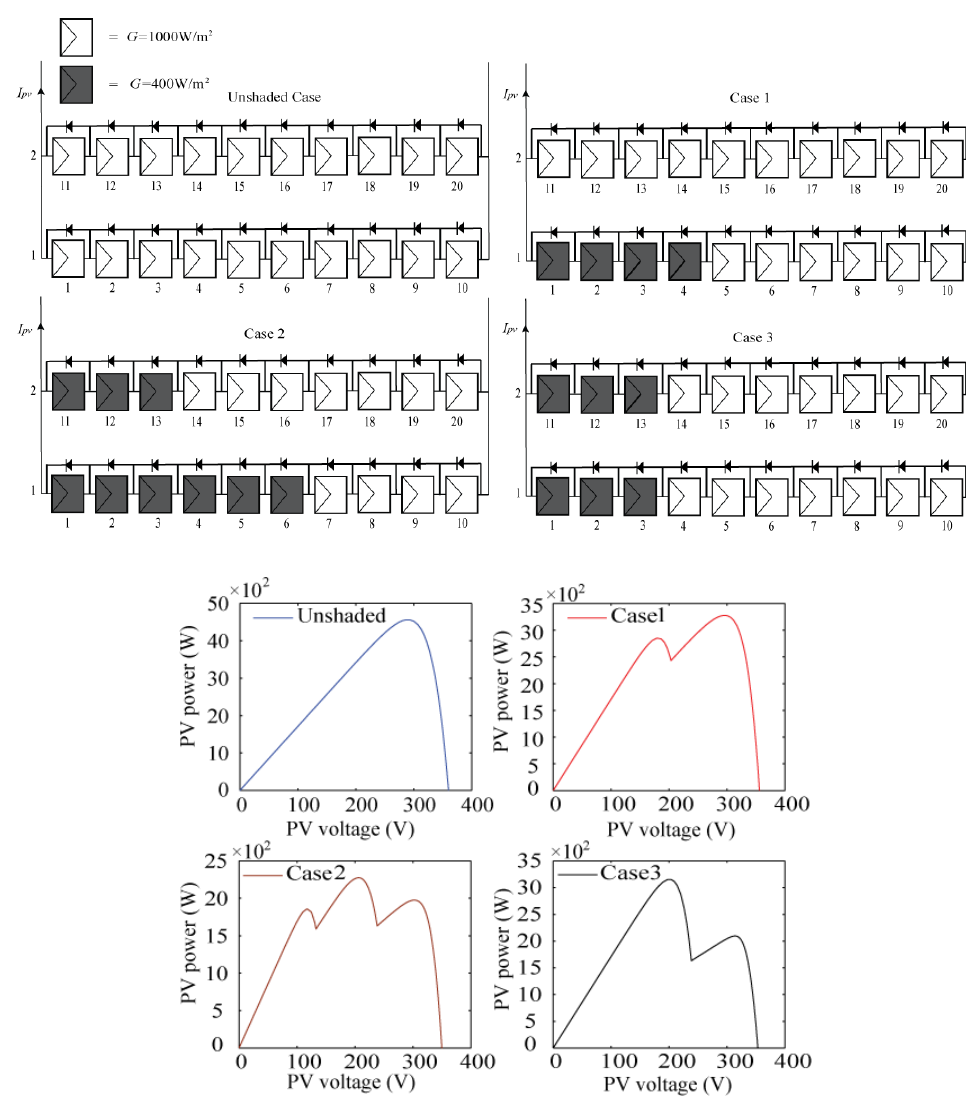
Figure 4. Output P–V characteristic curves under different shadow distribution cases under study.